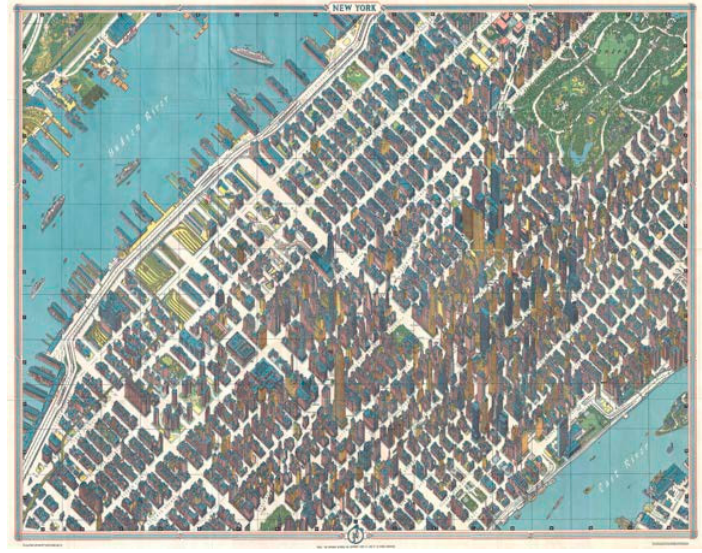
Figure 2. Hermann Bollmann, New York Map,